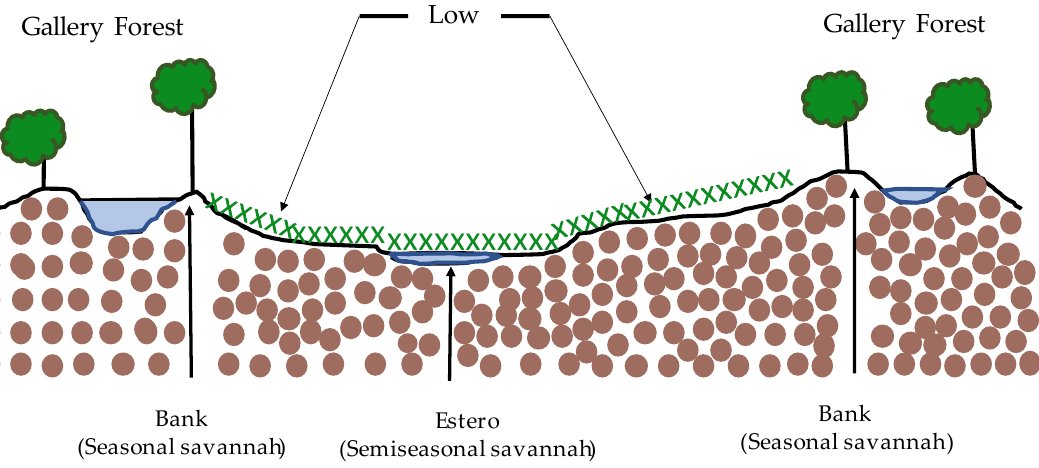
Figure 3. Topographic profile of the “bank” and “low” physiographic positions present in the Ar-